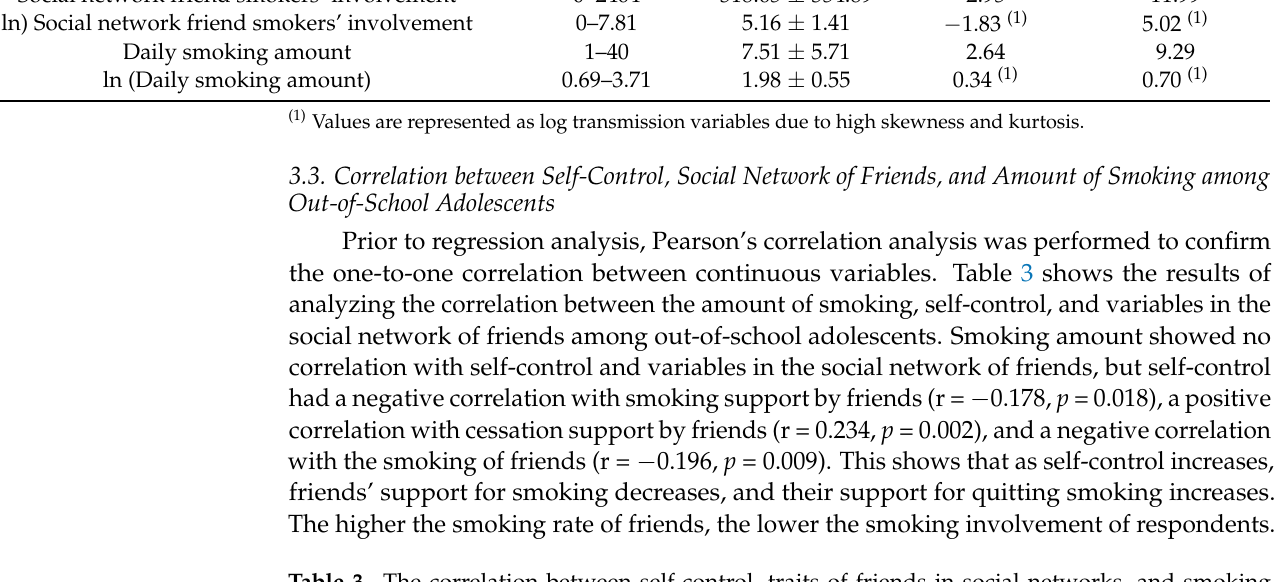
Table 3. The correlation between self-control, traits of friends in social networks, and smoking amount among out-of-school adolescents ( N =